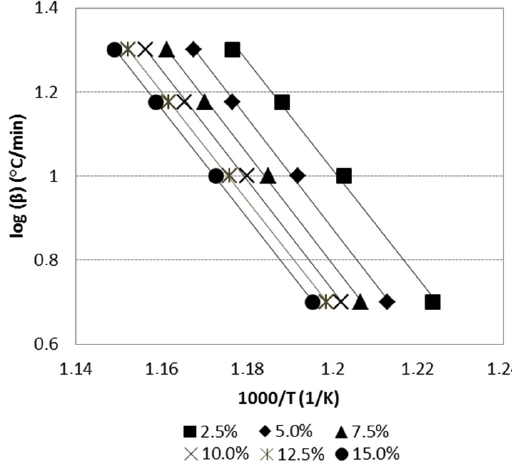
Figure 3. Plot of log (b) versus 1000/T and mathematical adjustment by least squares method for the conversion rates of 2.5%, 5%, 7.5%, 10%, 12.5% and 15%.